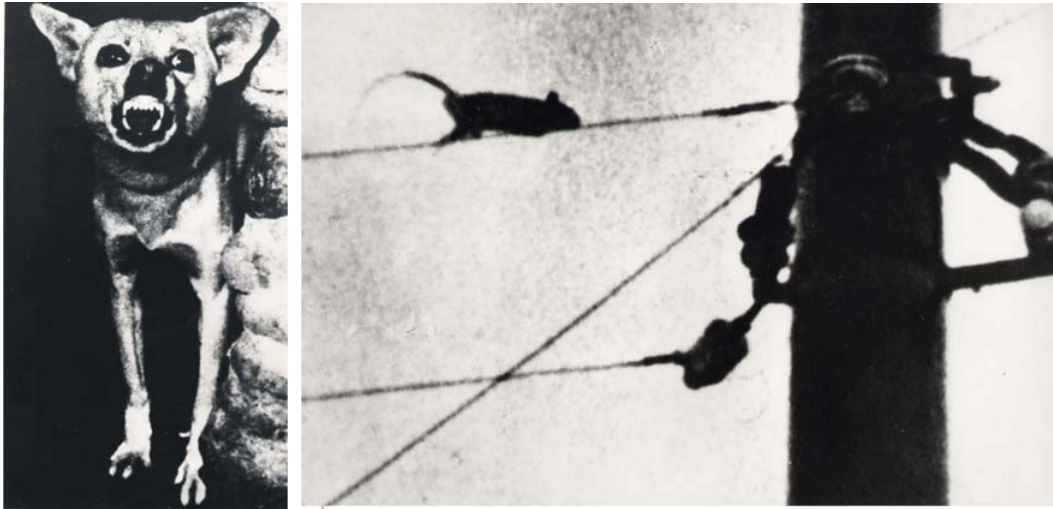
Figure 2. Pictures of an excited dog, and of a fleeing rat, which were taken prior to the M = 7.2 Sungfan-Pingwu earthquake from